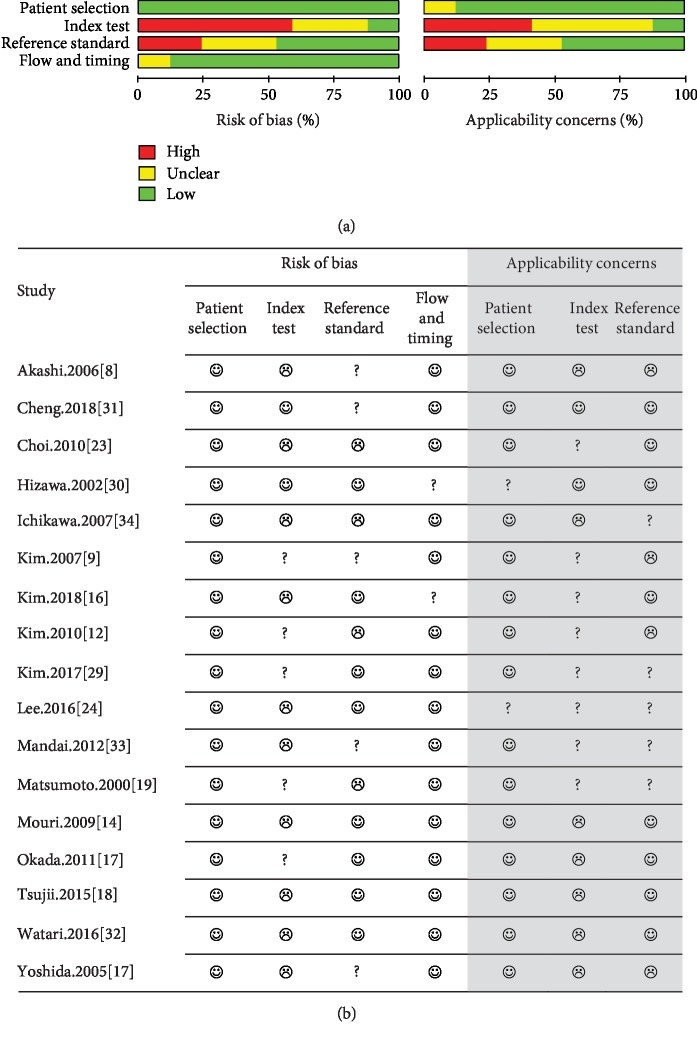
Quality evaluation table. (a) Proportion of studies with low, high, or unclear risk of bias and concerns regarding applicability; (b) methodological evaluation according to QUADAS-2. ☺: low risk; ☹: high risk; ?: unclear risk.